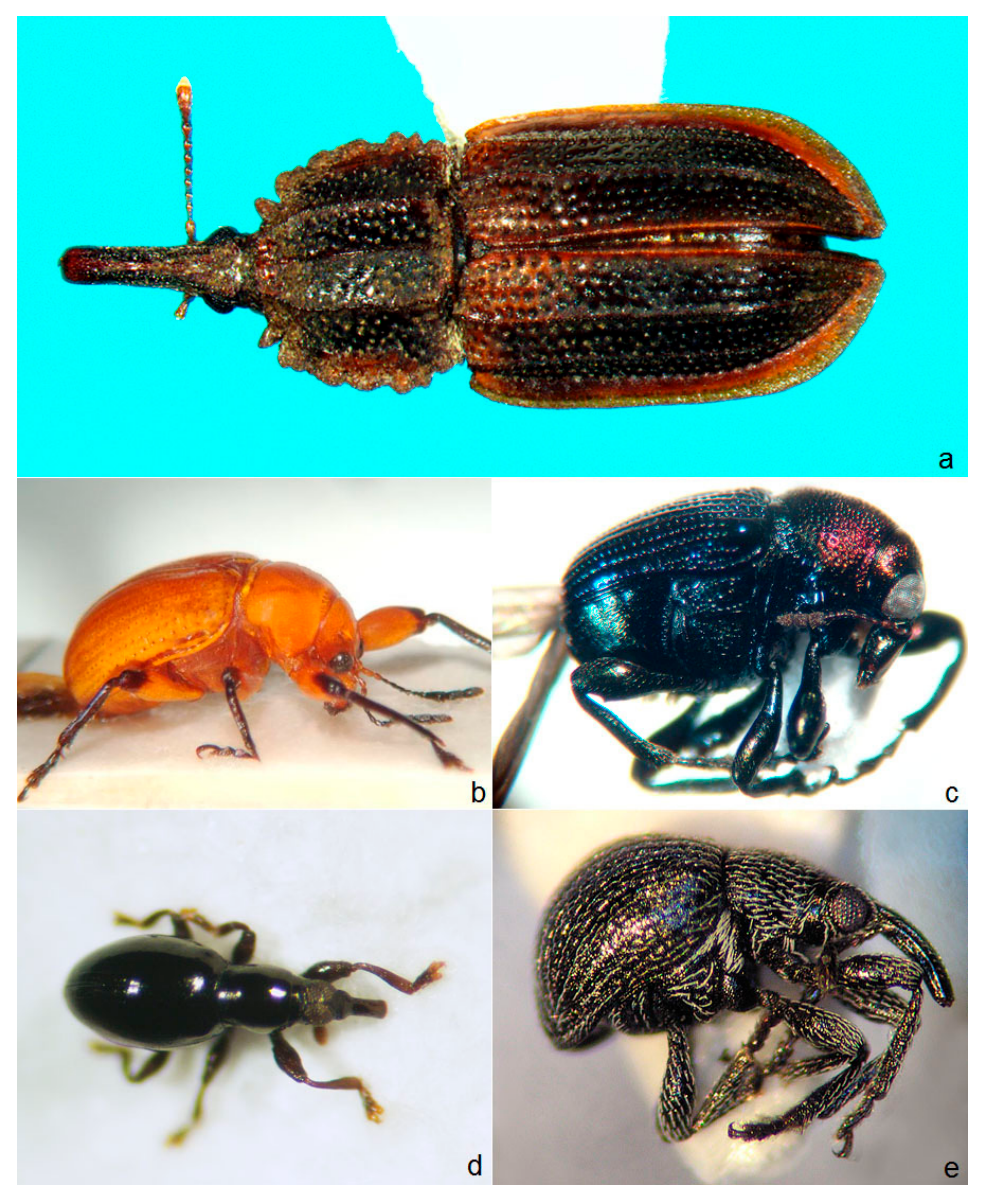
Figure 1. Metrioxena s.l., now. to Vladimirixena sp. (Belidae) ( a ); Allolabus sp. ( b ); Euops sp. (both Attelabidae) ( c ); Ommatocybus sp. ( d ); and a new species of the tribe Ixapiini (both Apionidae) ( e ).